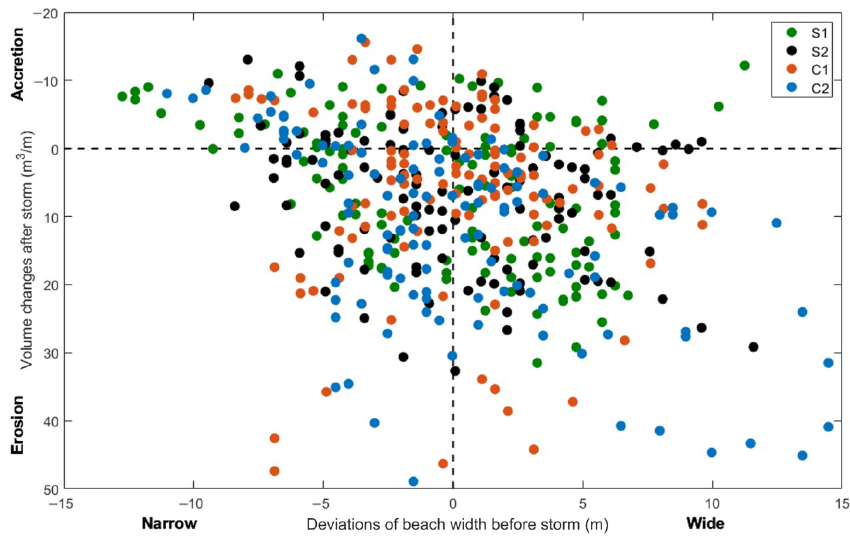
Figure 4. Subaerial volume changes according to beach width observed at the pre-bathymetry survey at each storm condition (S1 to C2).